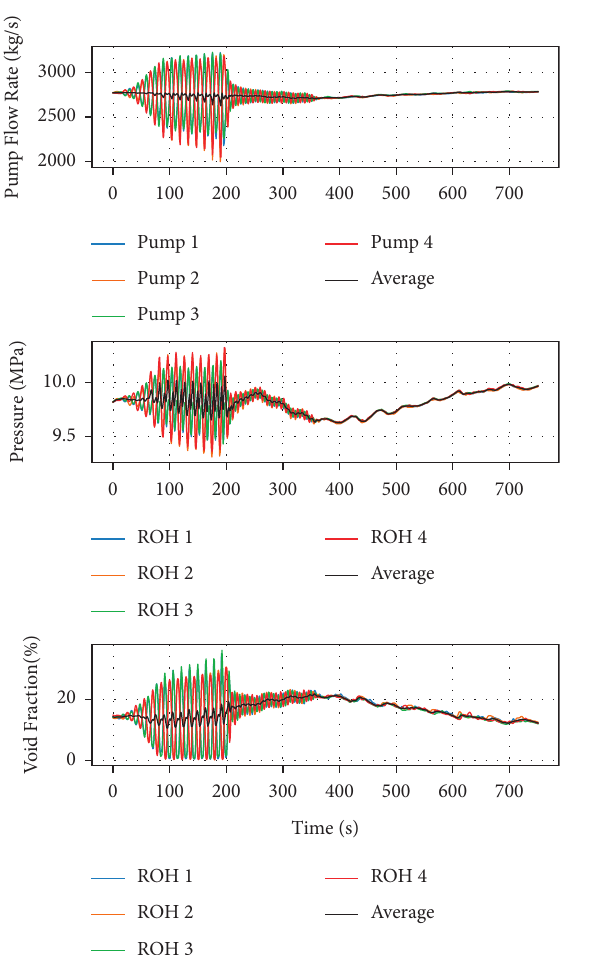
Figure 27: Flow rate oscillations at reduced pressure with blocked header interconnects. The even pair of pumps and headers oscillate out-of-phase with the odd pair.